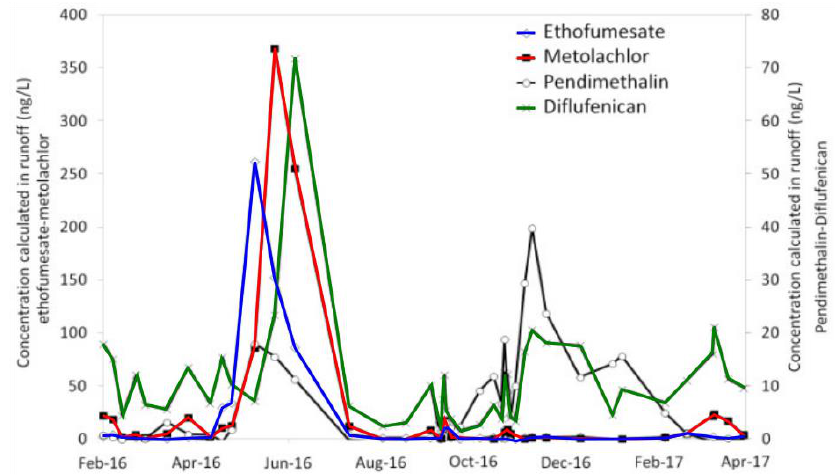
Figure 8. Reconstructed concentrations at Canche 5 of diflufenican, ethofumesate, metolachlor, and pendimethalin in surface runoff water.